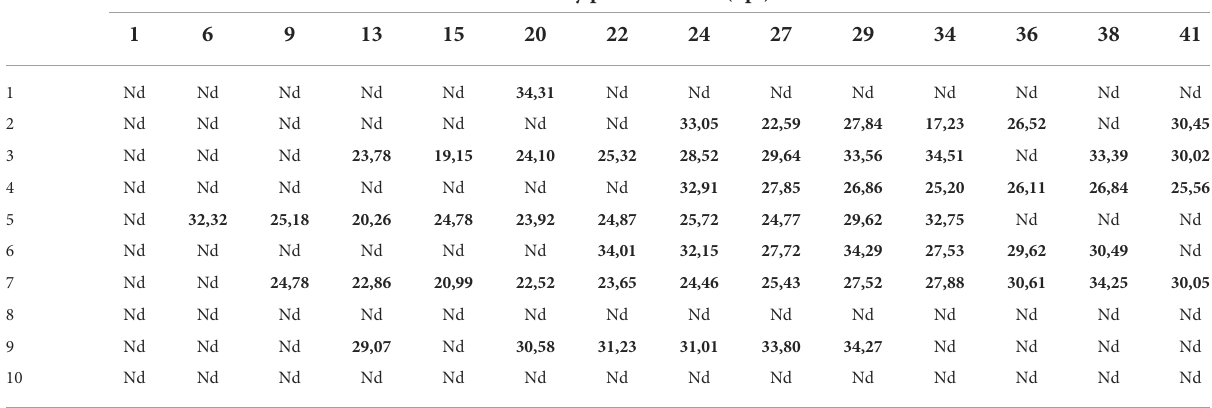
TABLE 2 Real time PCR results detecting the presence of LSDV in blood (Ct values). No. bull